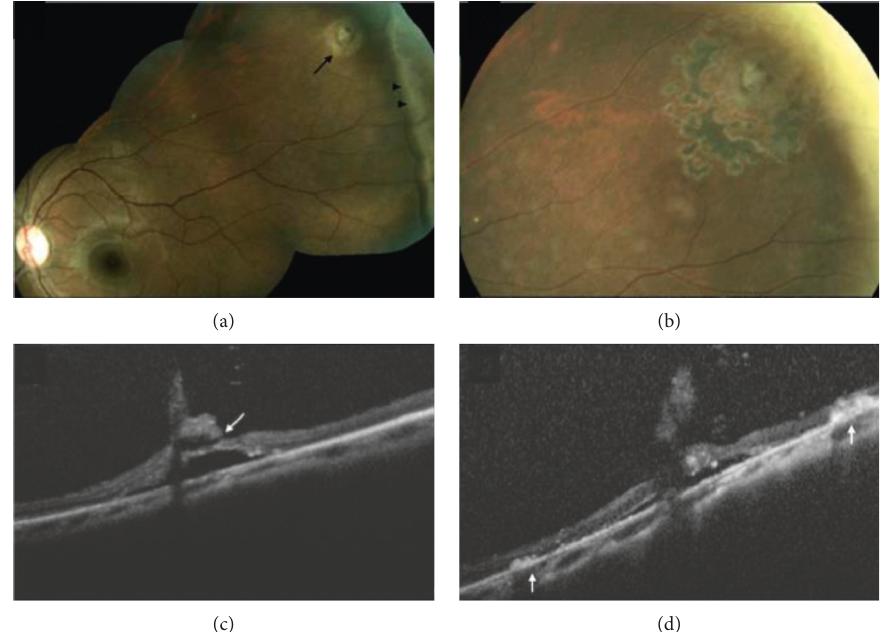
Figure 3: Peripheral SD-OCT before and after laser retinopexy for cystic retinal tuft with retinal break. (a) Fundus photograph of the left eye demonstrating cystic retinal tuft with retinal break (arrow) and white without pressure (arrowheads). (b) Appearance one month following laser retinopexy, demonstrating pigment corresponding to laser applications. (c) SD-OCTof the lesion before treatment, demonstrating full- thickness break with the tuft (arrow). (d) SD-OCT one week following laser treatment reveals outer retinal hyper-reflectance and early retinal pigment epithelium (RPE) pigment migration (arrows) corresponding to laser